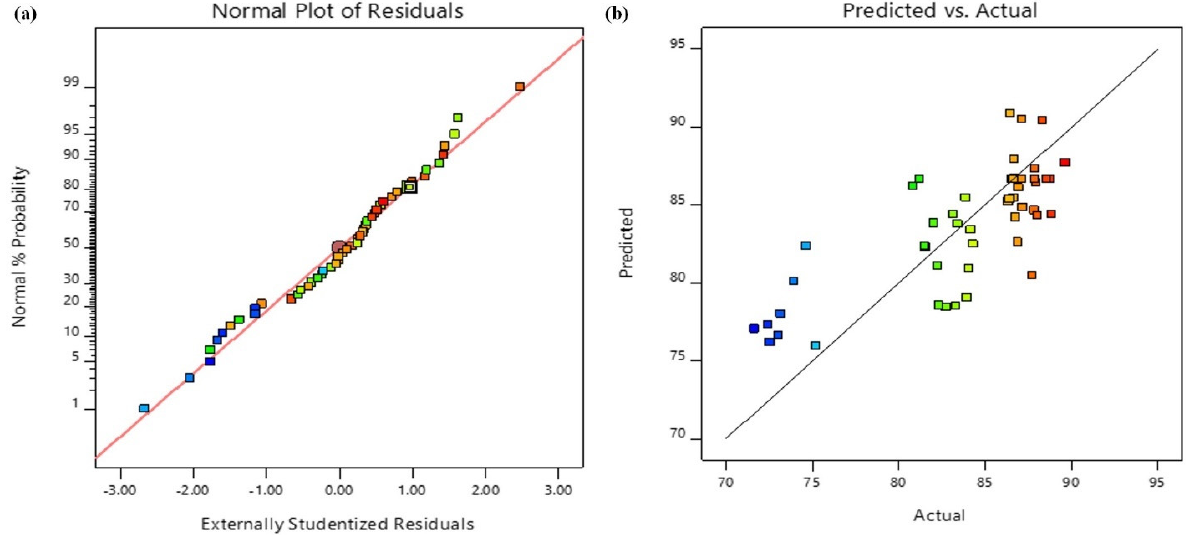
Figure 9. Design ‐ expert plots of ( a ) normal probability curve of the residuals and ( b ) relationship between actual values and predicted values for Pb removal.